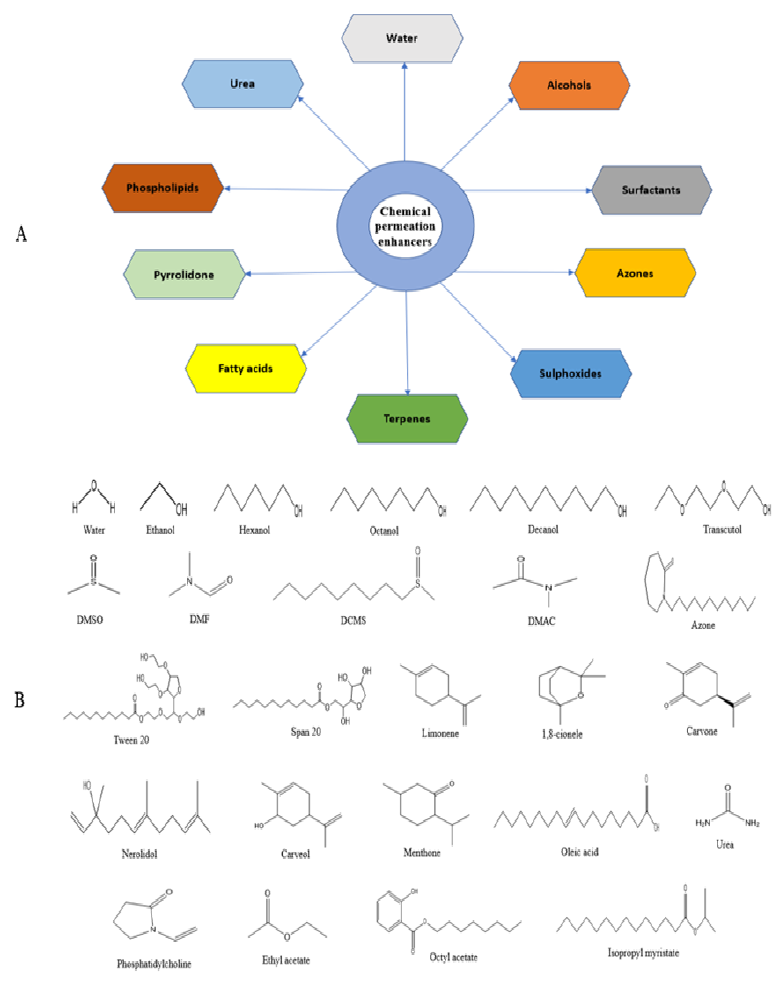
Figure 6. ( A ) Various types of chemical permeation enhancers used in TDDSs and ( B ) 2D-chemical structures.